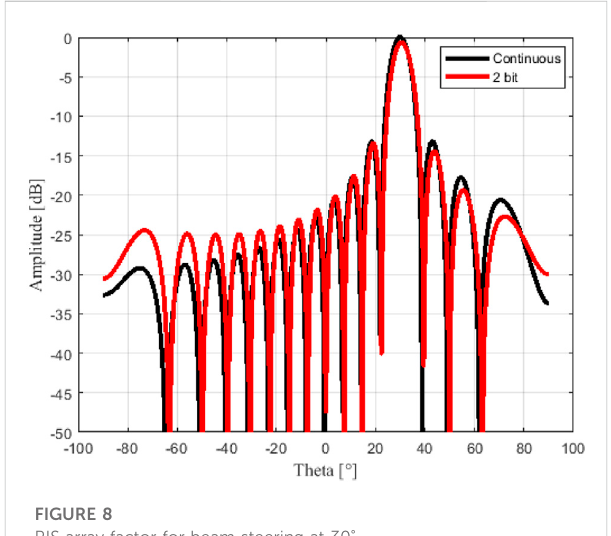
FIGURE 8 RIS array factor for beam steering at 30 °